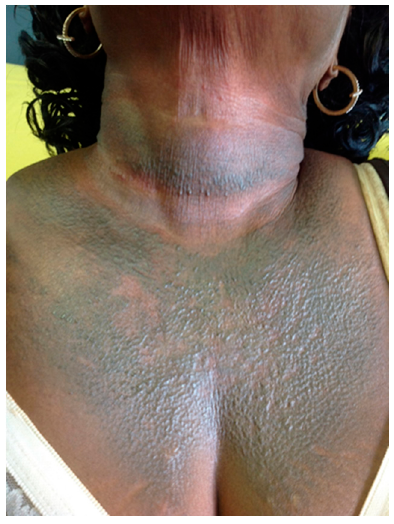
Figure 1. Severe ochronosis in a 48-year-old black female post hydroquinone use.